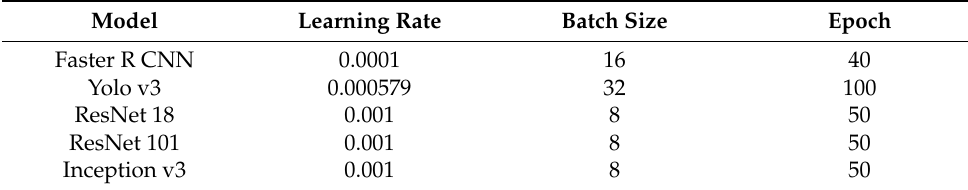
Table 4. Training parameters of each CNN.